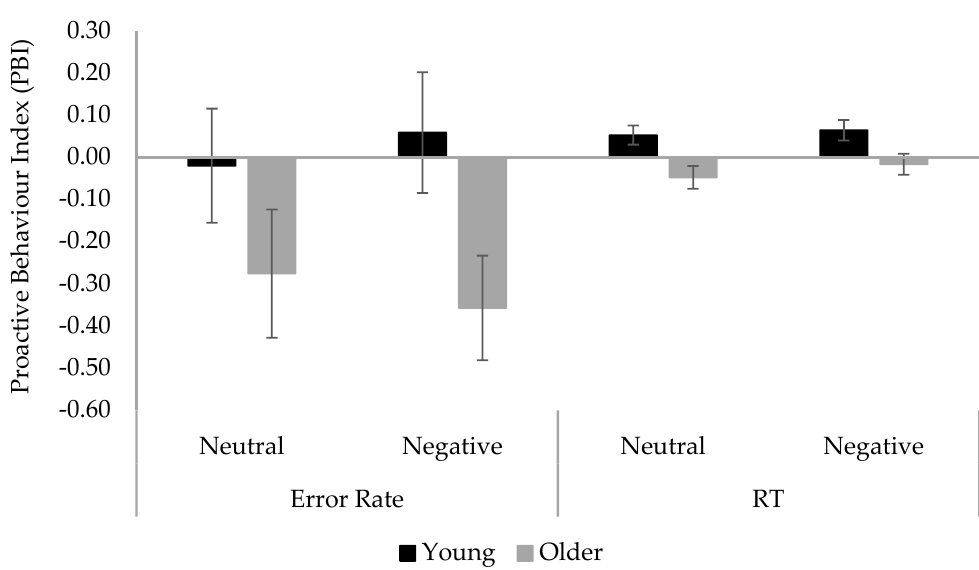
Figure 3. Mean Proactive Behavior Index (PBI) in error rate and RT across age and mood conditions in Experiment 1. Error bars denote standard error.